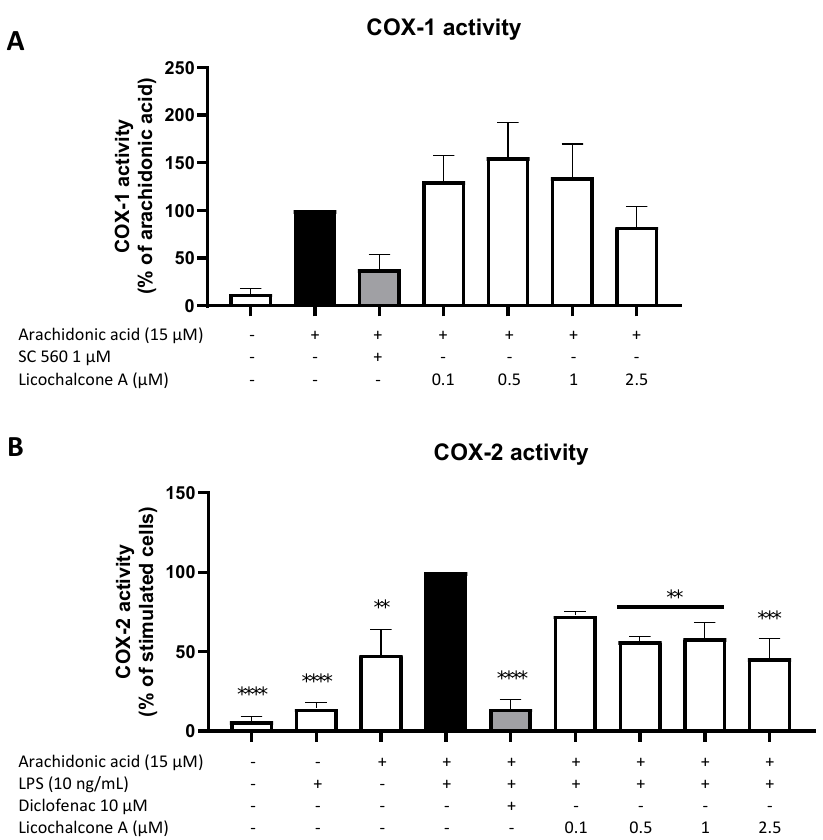
Figure 5. Effects of Licochalcone A on COX-1 ( A ) and COX-2 ( B ) activity in primary rat microglial cells. Cells were stimulated and COX-1/COX-2 activity assays performed as described under materials and methods. Values are presented as the mean ± SEM of at least three independent experiments. Statistical analysis was performed using one-way ANOVA with Dunnett’s post hoc tests with ** p < 0.01, *** p < 0.001, and **** p < 0.0001 compared to AA ( A ) or AA + LPS ( B ) stimulated cells.